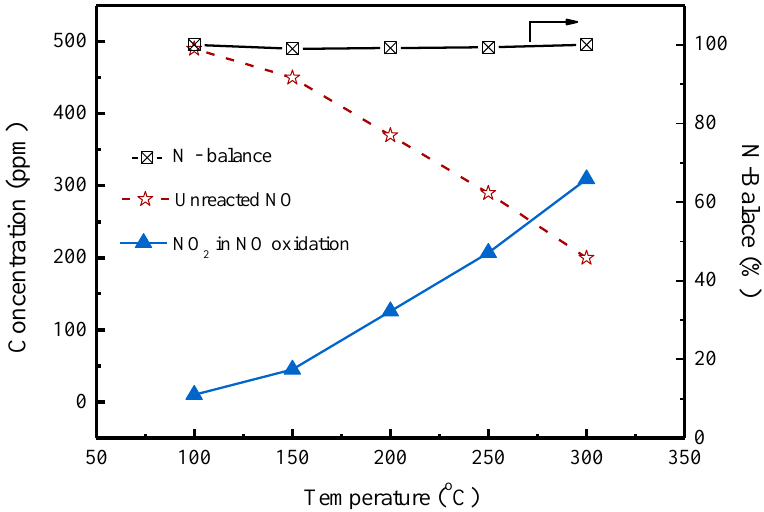
Figure 1. N-balance and outlet gas concentrations in the NH 3 oxidation reaction without SO 2 over MnFe/TiO 2 catalyst at different reaction temperatures. Reaction conditions: [NH 3 ] = 500 ppm, [O 2 ] = 10%, balanced with N 2 , GHSV = 50,000 h −1 .